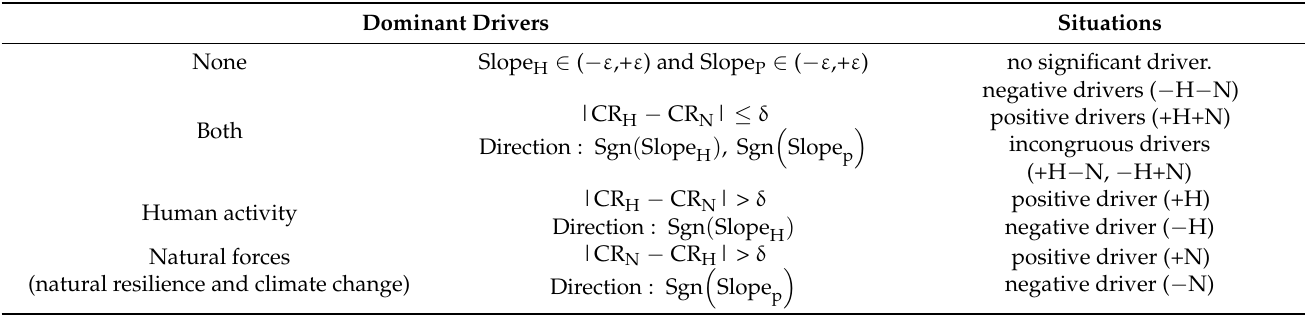
Table 2. Dominant drivers of ecosystem